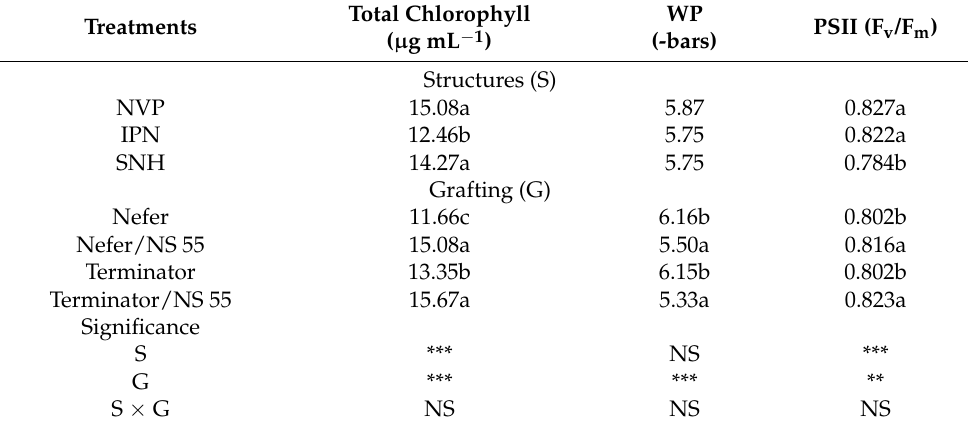
Table 6. Effect of structures and graft combinations on physiobiochemical